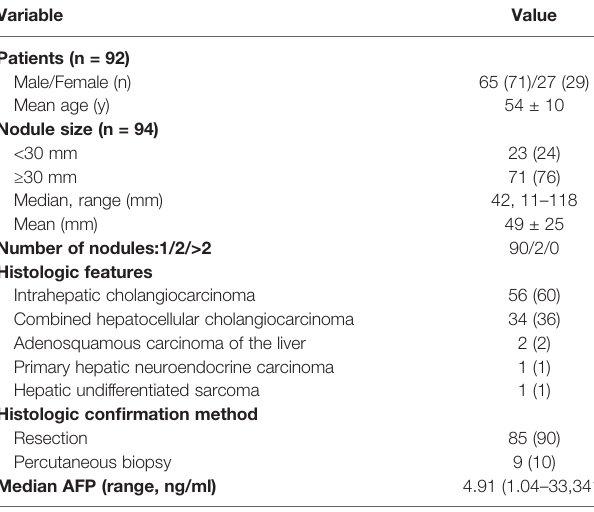
TABLE 2 | Patient and Nodule